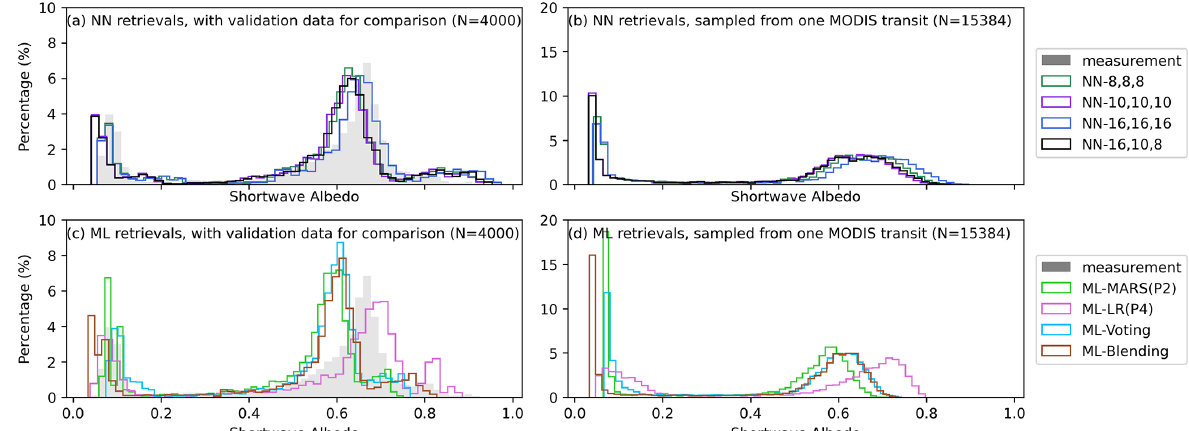
Figure B1. The top and bottom rows show a comparison of the retrieval results from four MLANN models and four ML models, respectively. The validation results of the eight selected models against aircraft measurements are provided in Table B1. Histograms of the measurements are presented as a reference (gray areas) in (a) and (c) . Panels (b) and (d) are sampled retrieval results using data from the MODIS transit at 14:00UTC on 25 June